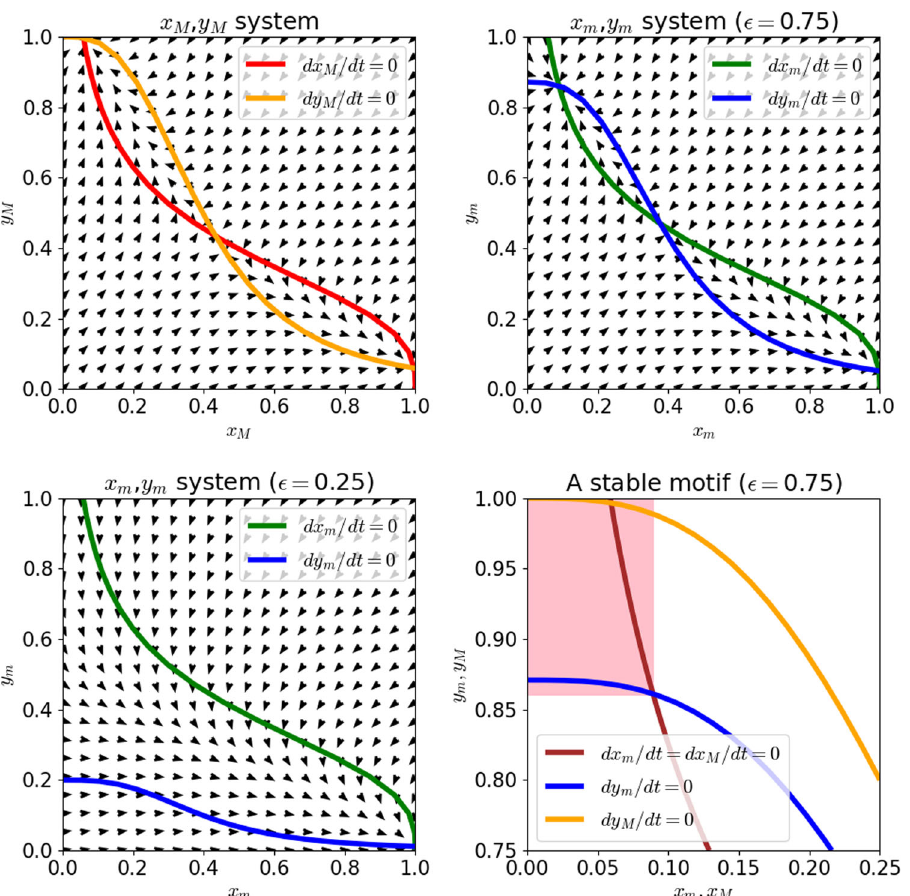
Fig. 3 Phase portraits and nullclines of the bounding systems of Eqs. 8 and 9. The phase portrait of the bounding x M ; y M system is depicted in the top left. The trajectories of the x,y system are such that x t ð Þ (cid:7) x M t ð Þ and y t ð Þ (cid:6) y M t ð Þ . The phase portrait of the x m ; y m system is depicted in the top right and bottom left corners for two values of the parameter ϵ . For ϵ ¼ 0 : 75 (weak control strength), the system exhibits a steady state with small x and large y . Because x m t ð Þ (cid:7) x t ð Þ (cid:7) x M t ð Þ and y m t ð Þ (cid:6) y t ð Þ (cid:6) y M t ð Þ both hold, this steady state implies the existence of a subset of the state space that cannot be escaped by varying u t ð Þ in Eq. 6; this region is highlighted in red in the bottom right fi gure. Note that in the strong control case ( ϵ ¼ 0 : 25 ), there is no such steady state in the bounding system, and thus the control is able to drive the system from a low- x , high- y state to a high- x , low- y